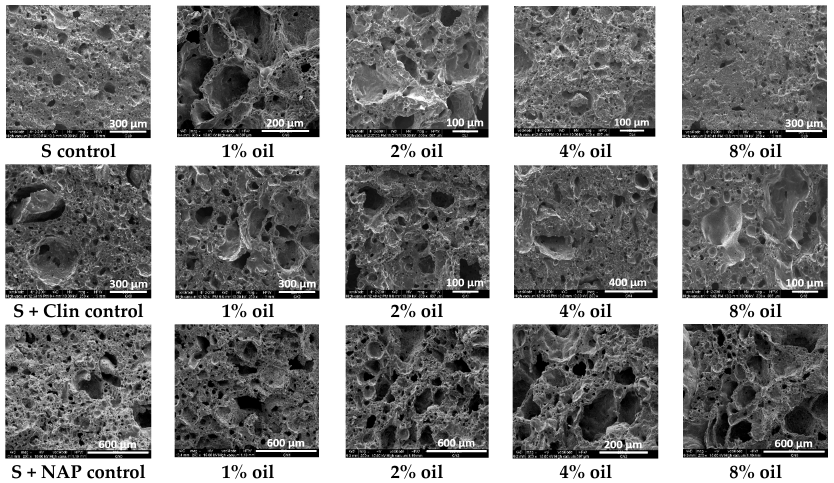
Figure 3. Representative scanning electron microscope (SEM) microphotographs of the studied aggregate sections.